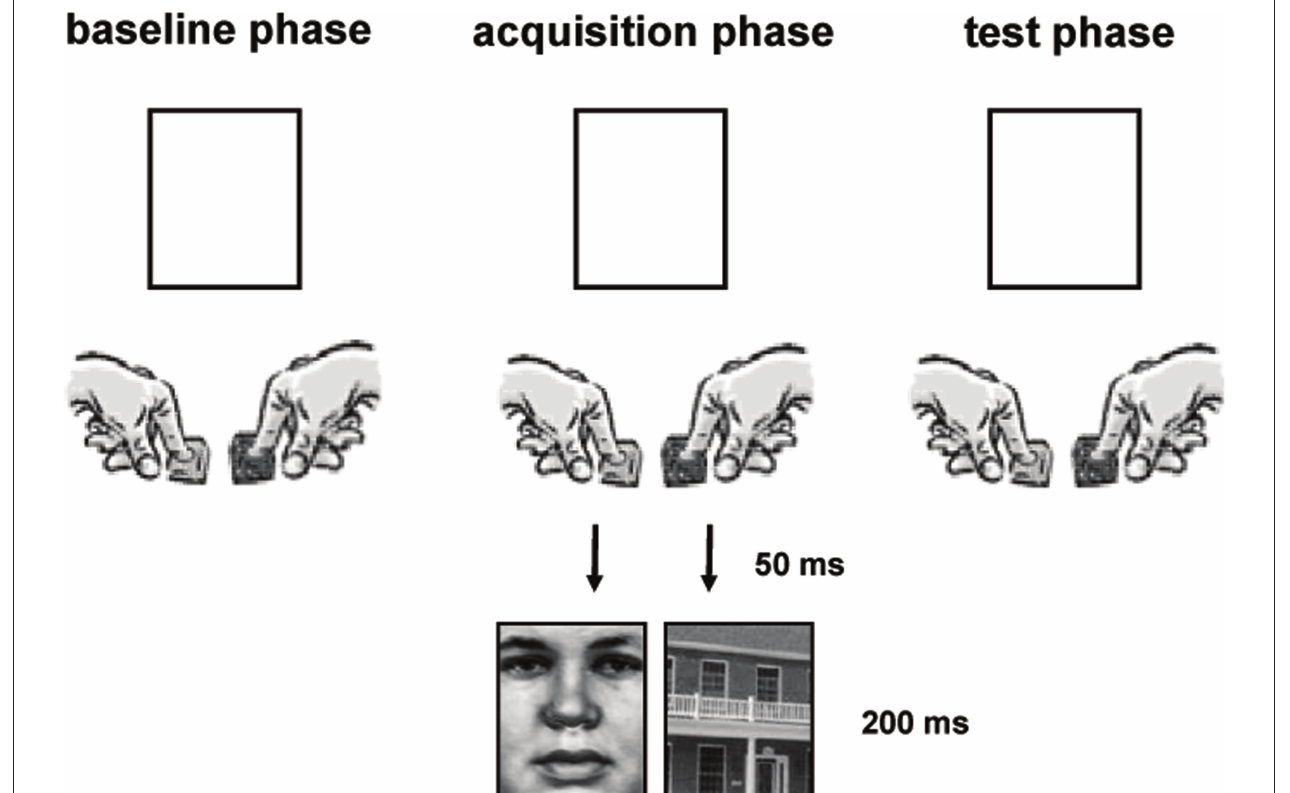
Figure 1 | Schematic drawing of the experimental